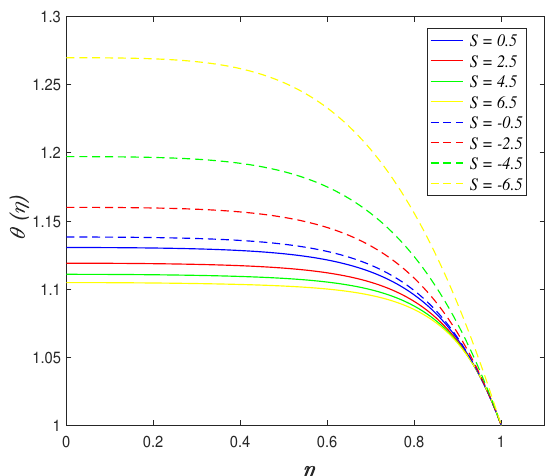
Figure 4. Impact of S on temperature.